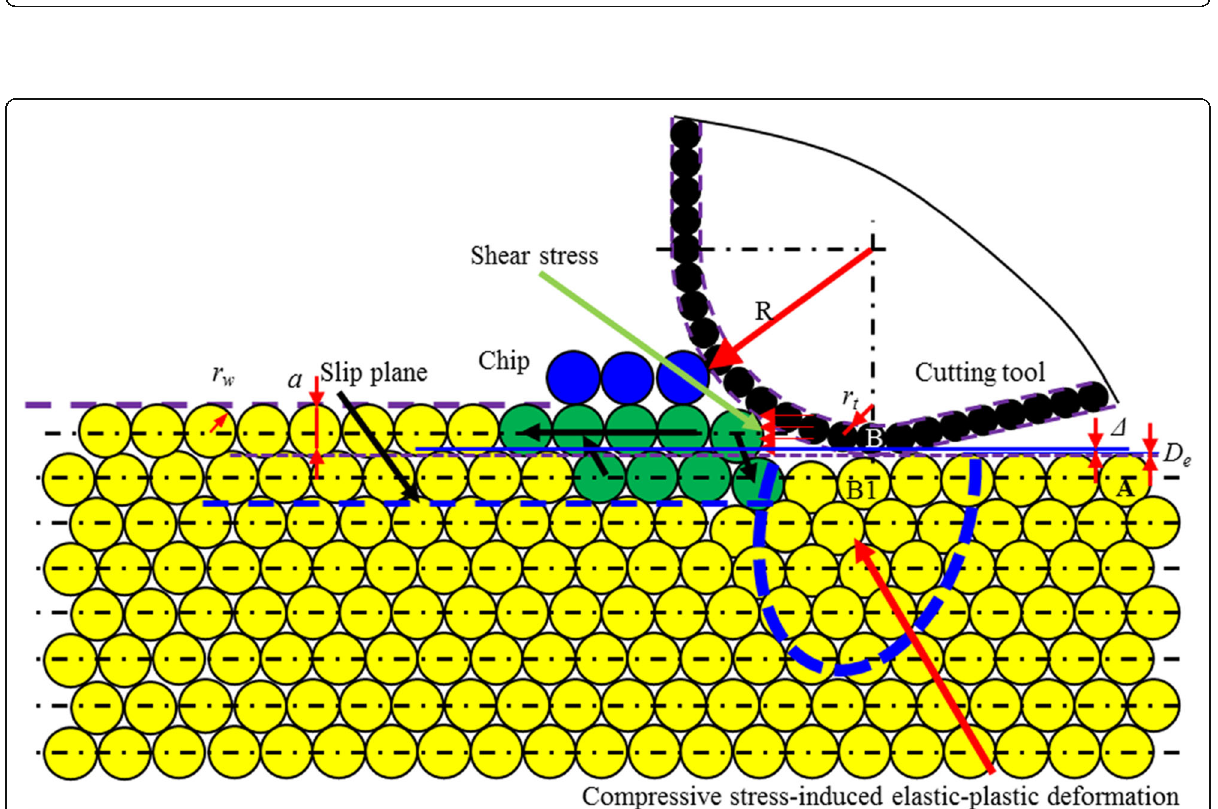
Fig. 18 Schematic illustration of cutting-based single atomic layer removal at a/r w larger than C 2 , a/R larger than T 2 , smaller than T